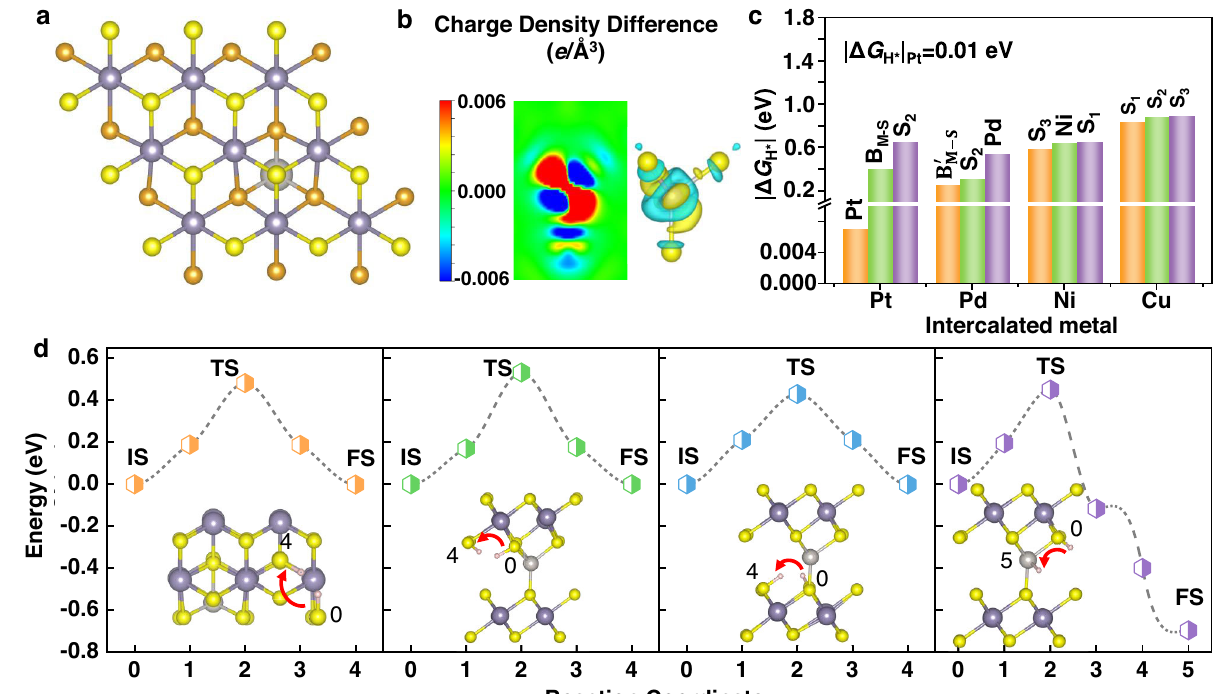
Fig. 4 | The theoretical calculation of SA-intercalated SnS 2 . a The relaxed Pt- intercalated SnS 2 crystal structure. Yellow: S atoms on the upper surface of SnS 2 . Orange: S atoms on the lower surface of SnS 2 . Purple: Sn atoms of SnS 2 . Gray: the intercalated Pt atom. b The localized charge density difference distribution of Pt-